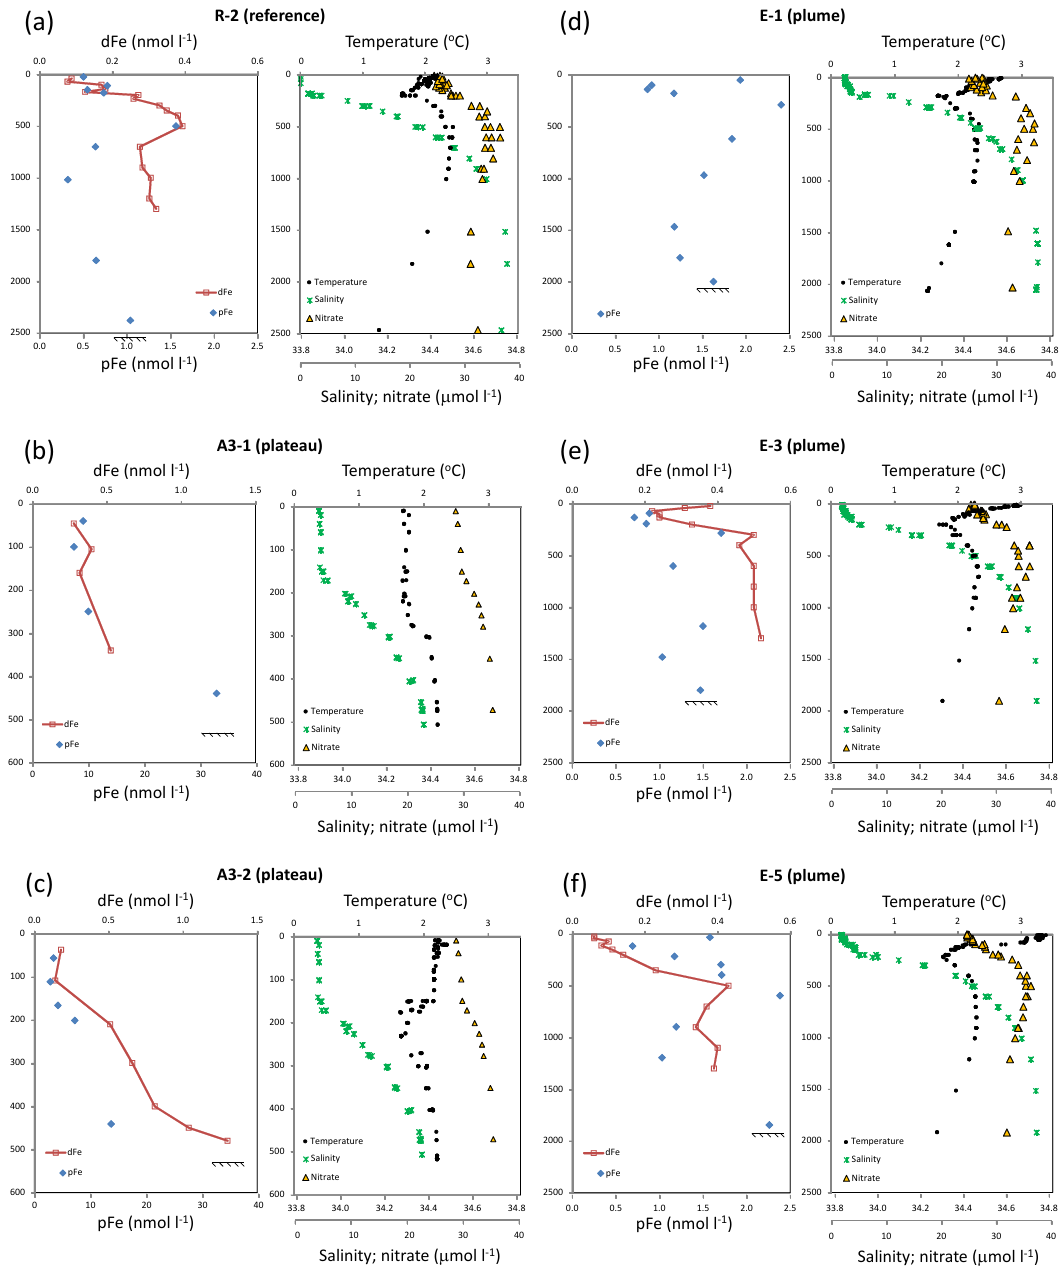
Figure 3. (a) Vertical profiles of dissolved iron (dFe) and particulate iron (pFe), potential temperature, salinity, and nitrate at reference station R-2. The seafloor depth at 2528m is shown. (b, c) Vertical profiles of dFe and pFe, potential temperature, salinity, and nitrate at plateau stations A3-1 (b) and A3-2 (c) . The seafloor depth at ∼ 530m is shown. Note different scales for dFe and pFe compared to R-2 and E stations. (d, e, f) Vertical profiles of dFe and pFe, potential temperature, salinity, and nitrate at plume stations E1 (d) , E3 (e) and E5 (f) . The seafloor depth ranging from 1905m (E3) to 2057m (E1) is